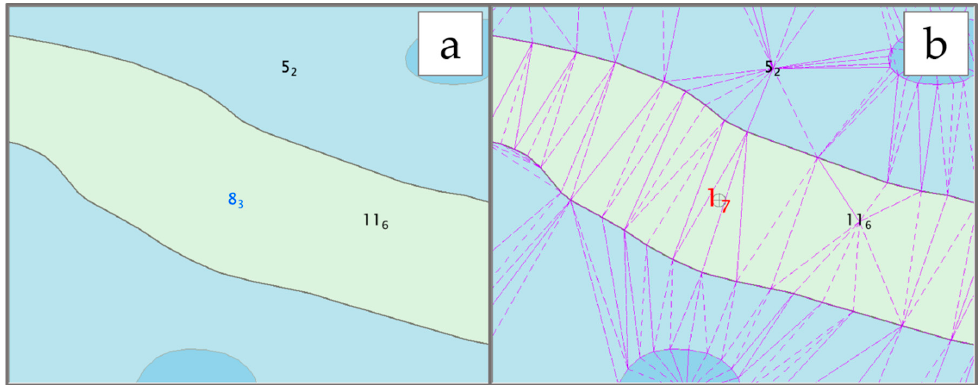
Figure 5. An example of the presence of a survey sounding in a flat triangle. In the pane ( a ), an 8.3-m survey sounding (in blue) is surrounded by the nodes of a 10-m depth contour that are closer than the charted soundings (in black). As such, the survey sounding will be contained by a flat triangle (that is, with three vertices having a 10-m depth) shown in magenta in the pane ( b ). By adopting the sounding-in-specific-feature test, the algorithm flagged the survey sounding as a potential discrepancy (shown as grey circle with a depth difference of 1.7 m in red) since it was detected as contained by a depth area with a valid depth range between 10 and 20 m.